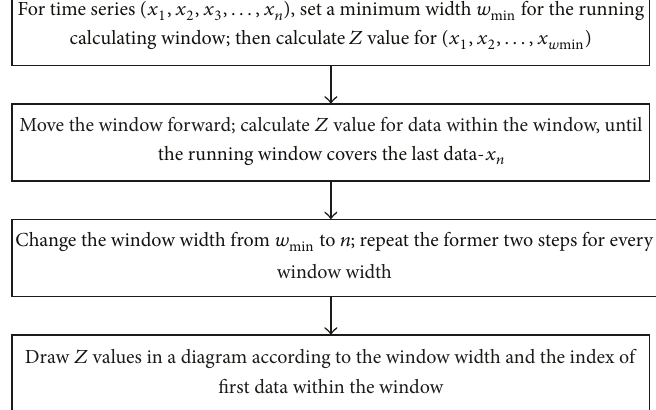
Figure 1: A schematic diagram of the MK trend test with a running